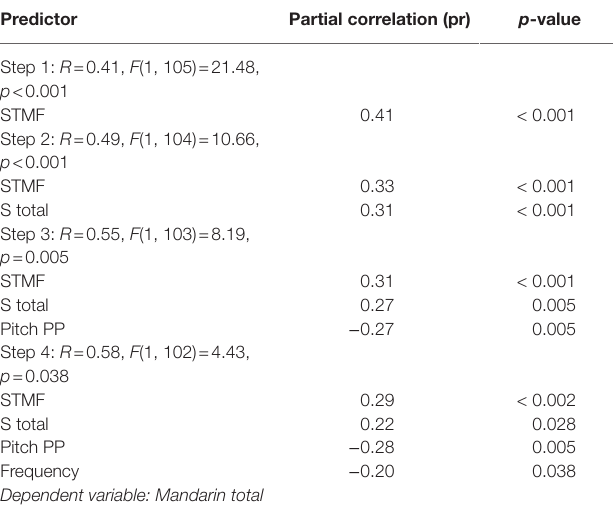
TABLE 3 | Multiple regression models explaining the variance in Mandarin total. Predictor Partial correlation